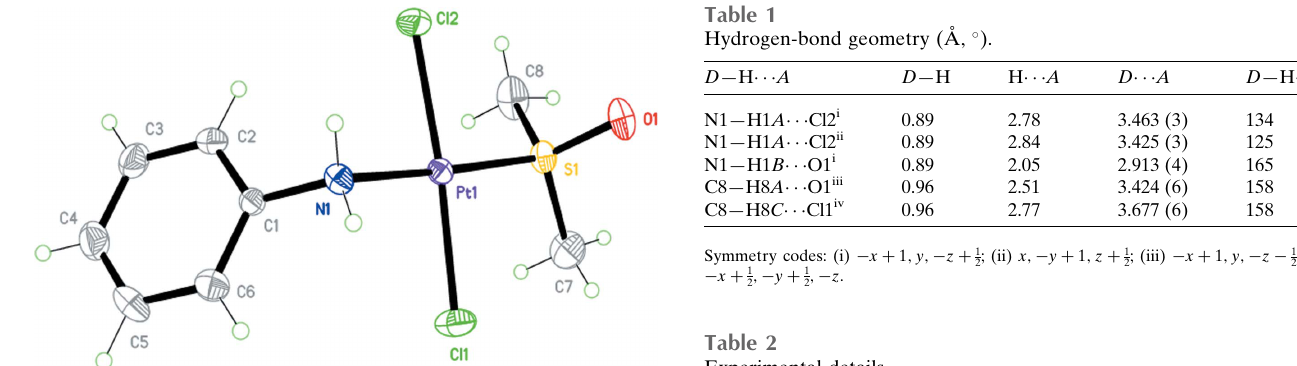
Table 2 Experimental details. Crystal data Chemical formula